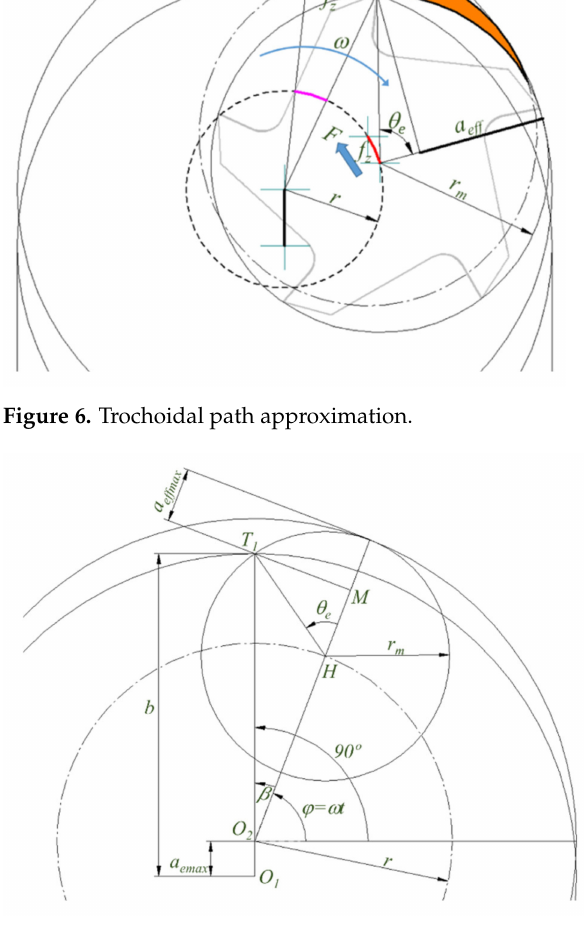
Figure 7. Instant in which a effmax is